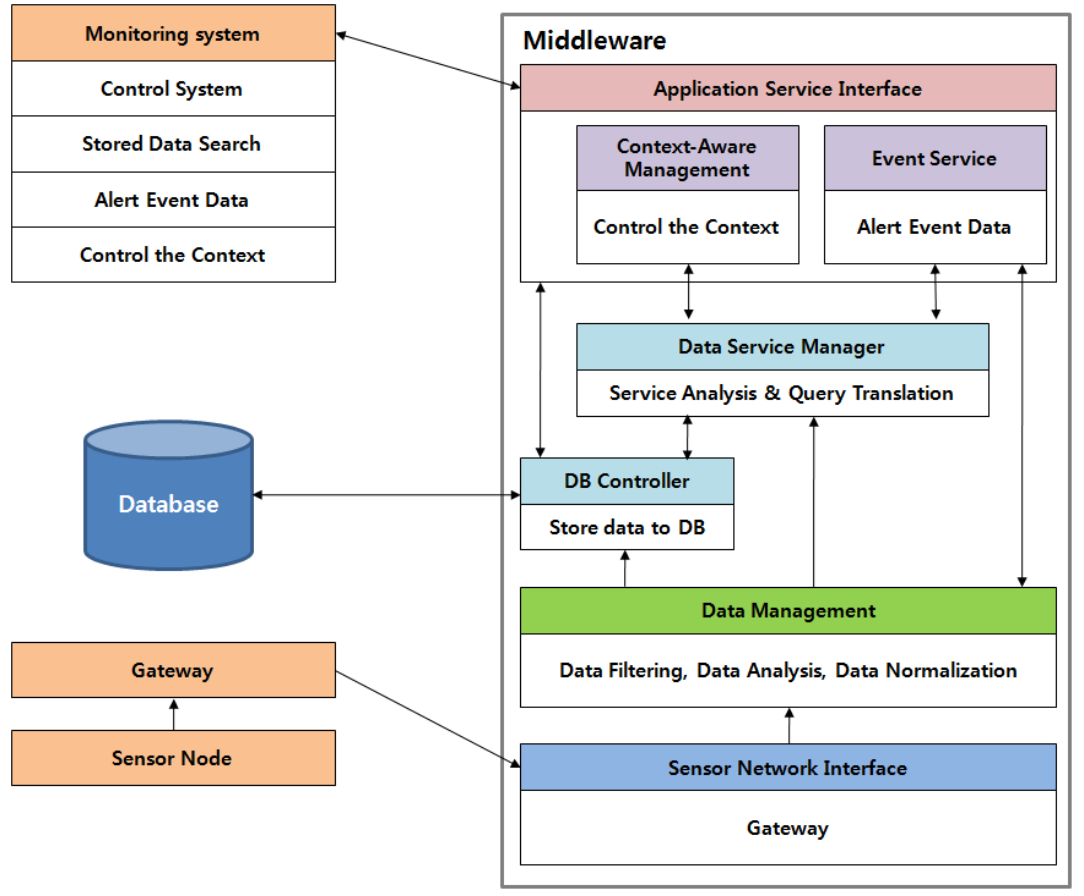
Figure 11. Structure and data flow chart of the proposed